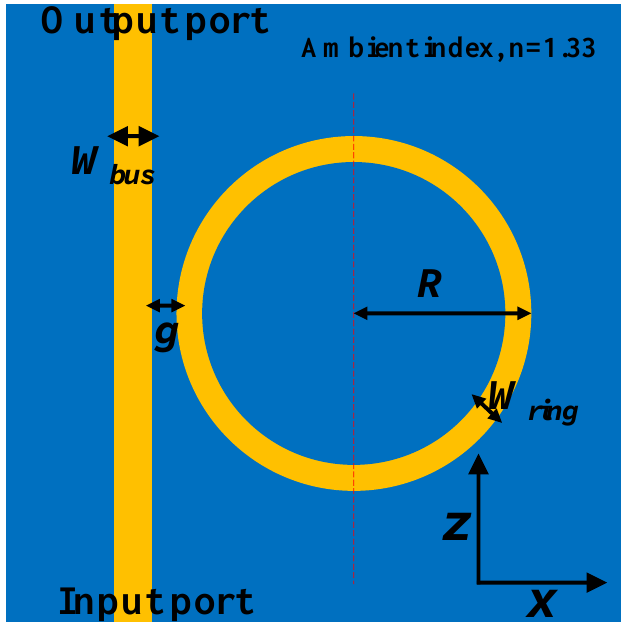
Figure 10. Schematic representation of an RR based on SiO 2 :TiO 2 optical WG. The radius of the ring (denoted as R ) was chosen to be 15 µ m based on the computa- tional limit of our computer. The coupling distance between the bus WG and the ring is denoted as g . The ambient medium was filled with a dielectric material of n = 1.33. From a practical point of view, the height ( H ) of the device design was fixed at 200 nm, which could be obtained in a single dip-coating process, and the n eff values of the Si WG were obtained from Figure 7. A TE-polarized plane wave was coupled at the input port of the bus WG, and the output power was collected at the other end. To determine the free spectral range (FSR) of the RR structure, the extinction ratio ( ER ) was calculated by using the following